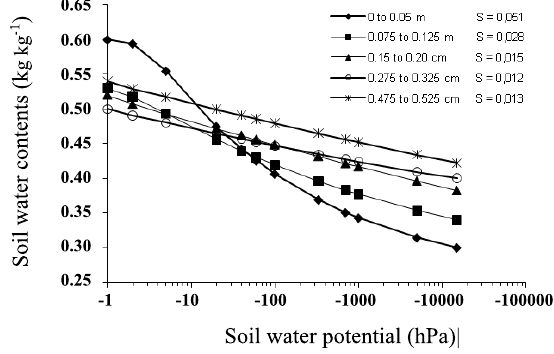
Figure 1. Soil water retention and S indices at the time the experiment was started, as affected by soil